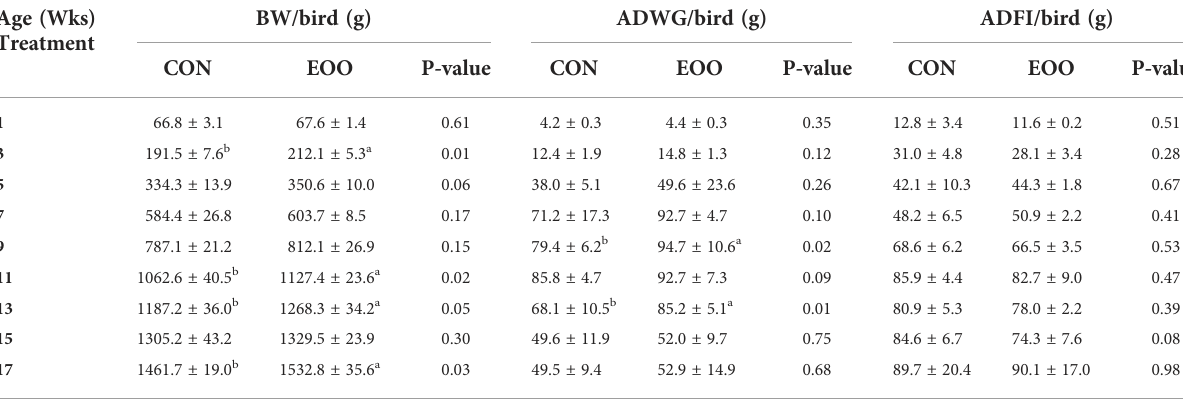
TABLE 3 Production performance measures of pullets from ages 1 to 17 weeks old. Age (Wks) Treatment